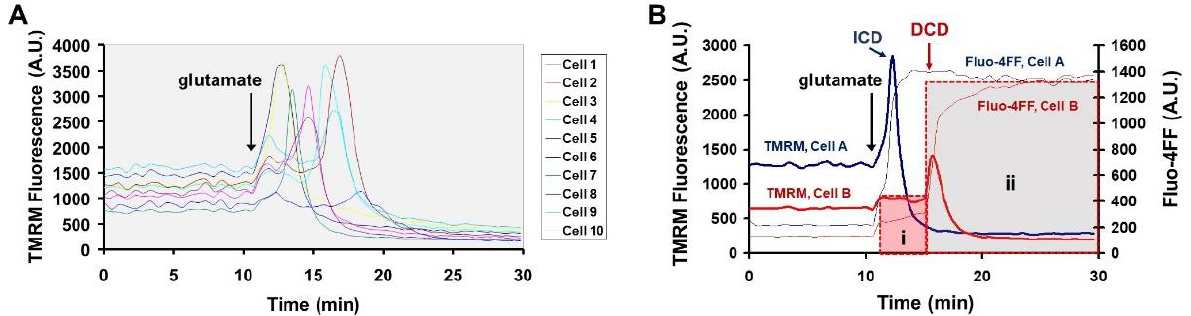
Figure 3. Mitochondrial depolarization timing in response to excitotoxic glutamate is stochastic and occurs simultaneous to Ca 2+ deregulation. ( A ) TMRM + fluorescence time courses from 10 representative individual neurons that were exposed to glutamate (100 µM) at the indicated time (arrow). ( B ) TMRM + (left axis) and Fluo-4FF (right axis) values over time from two representative cells that underwent either immediate Ca 2+ deregulation (ICD, Cell A, blue traces) or spontaneous delayed Ca 2+ deregulation (DCD, Cell B, red traces) following glutamate addition. Continuous traces were plotted from images taken at 30 s intervals. Time intervals “i” (pink shading) and “ii” (gray shading) illustrate the periods before and after DCD, respectively, with the central question of this study being whether glutamate stimulates protease activity during the “i” period prior to DCD.